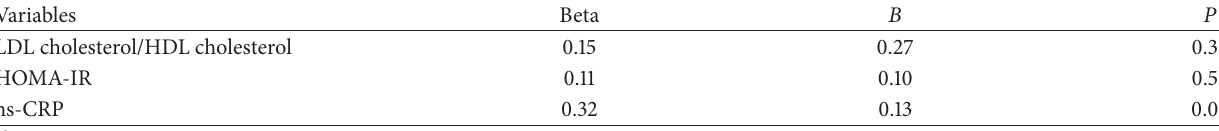
Table 2: Multivariate regression analysis for dependent variable glucose at 2 h OGTT in women with pt2DM.